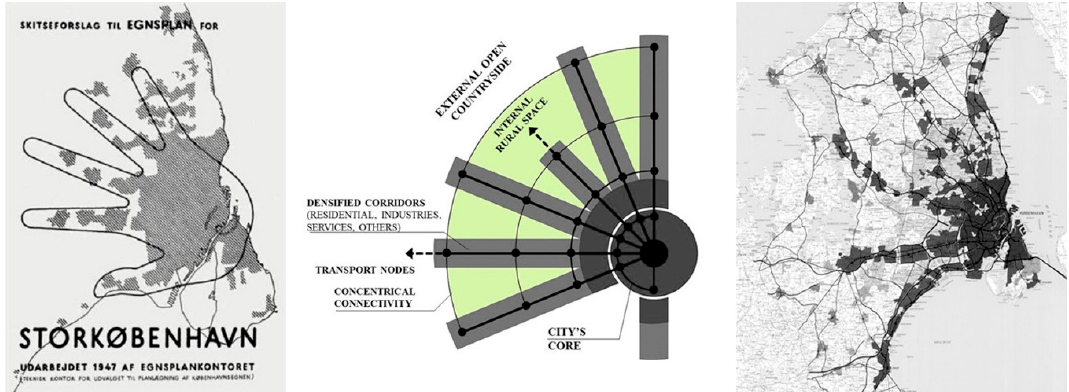
Figure 2. Map and diagrams of greater Copenhagen. ( left ) The original plan illustrating the morphological analogy of a “hand with fingers”. ( middle ) An abstraction of the general urban form composed of “open wedges” and densified corridors. ( right ) A map of Copenhagen (Author’s image). The Randstad zone in the Netherlands is another case-in-point. This is a regional urbanized area morphologically configured as a “ring” composed of the main cities of Rotterdam, The Hague, Amsterdam and Utrecht, and several towns in between. These urban areas circumscribe a large piece of countryside known as the “Green-Heart”, which supports agricultural production. Furthermore, between the cities and towns there are several small-scale rural spaces that host agricultural and public activities including parks, urban farmlands and ecological reservoirs (Figure 3). In this case,